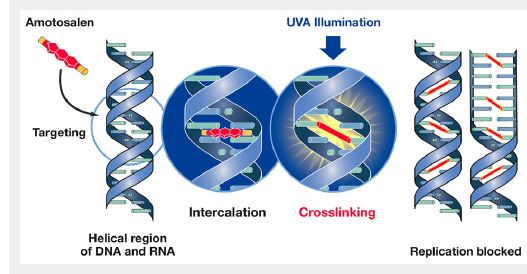
Pathogen reduction with the INTERCEPT ® method. Schematic representation of the mode of action of INTERCEPT ® . Amotosalen intercalates within DNA/RNA. DNA/RNA crosslinks upon UVA irradiation. This blocks reproduction of pathogens and leucocytes. Courtesy of Cerus Corporation, Concord, CA,